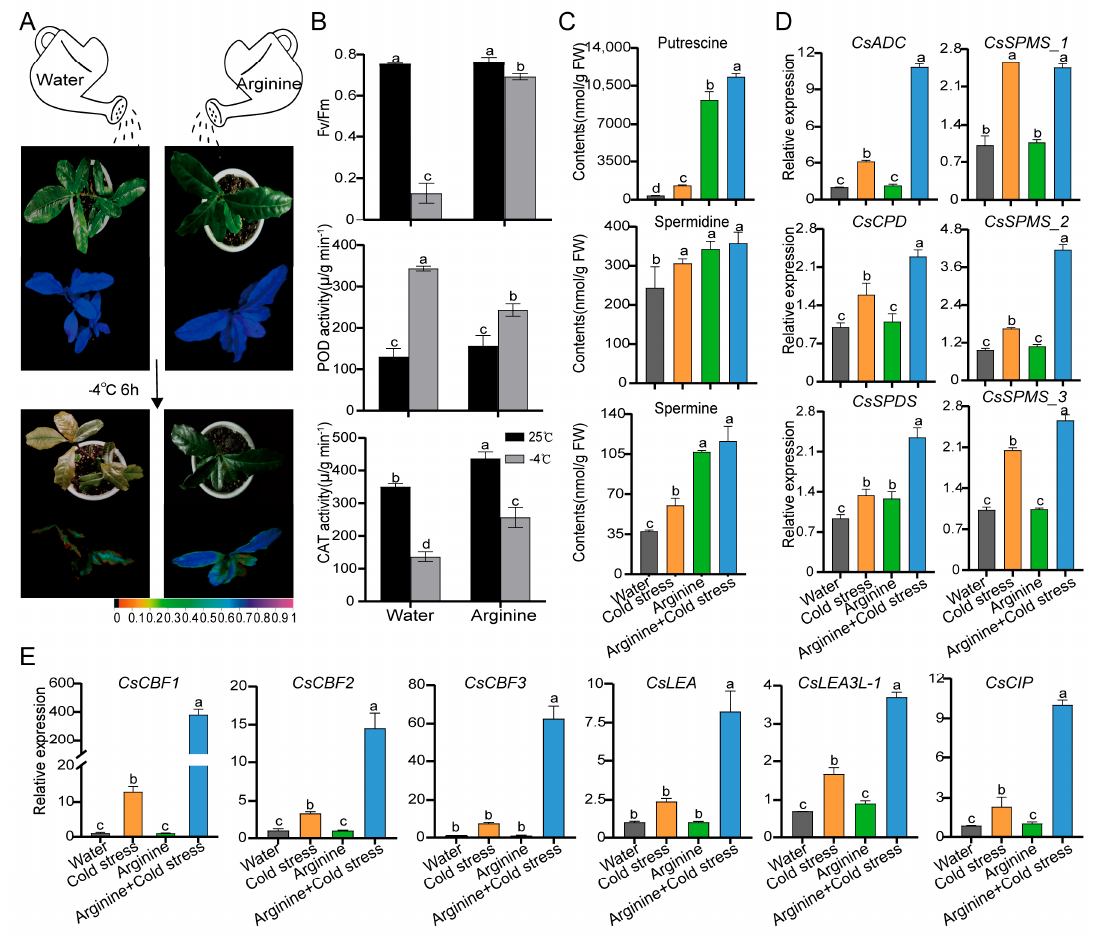
Figure 6. The effect of arginine on cold resistance in tea plants. ( A ) Phenotype of 1% ( w / v ) arginine and control group following freezing treatment ( − 4 °C, 6 h) and Fv/Fm imaging of chlorophyll fluorescence parameters. Purple and blue indicate the normal state of the photosynthetic system, while green and yellow suggest damaged photosystem II. ( B ) Statistical analysis of chlorophyll fluorescence parameter Fv/Fm ratio, POD activity, and CAT activity in tea leaves treated with